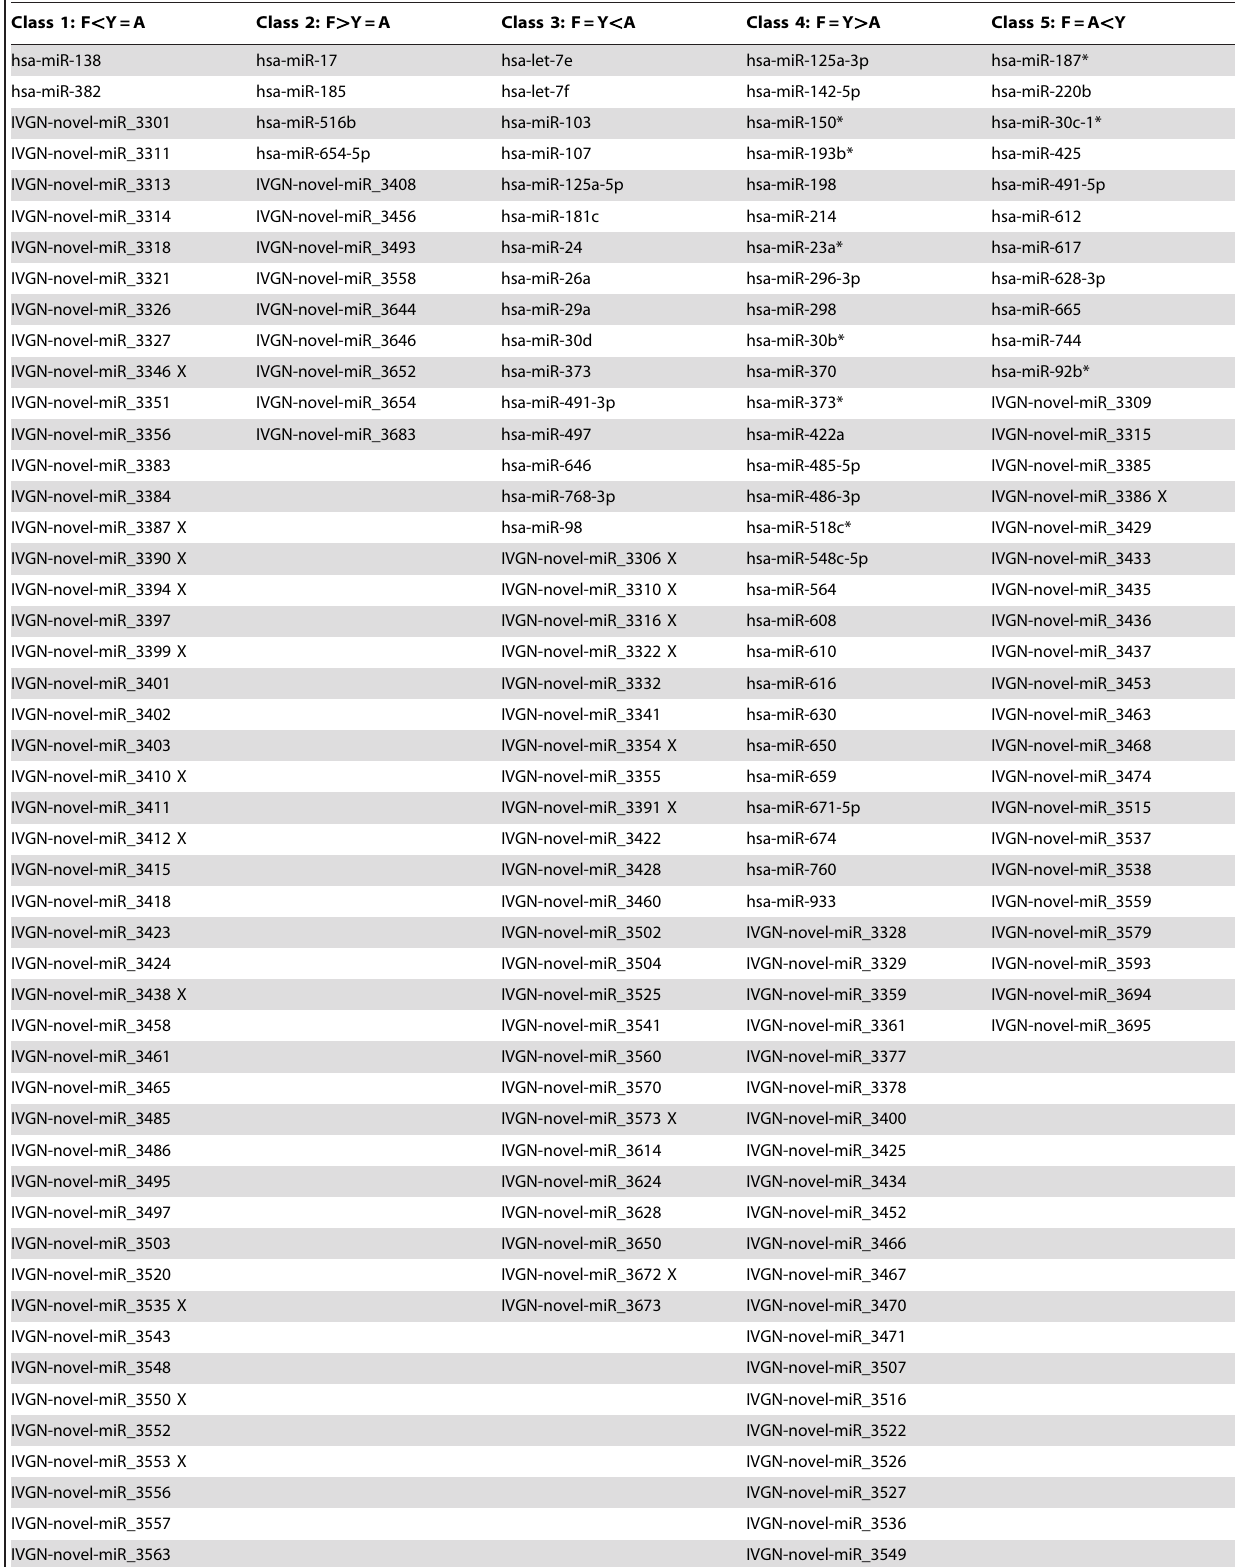
Table 2. Classifying miRNAs based on developmental expression